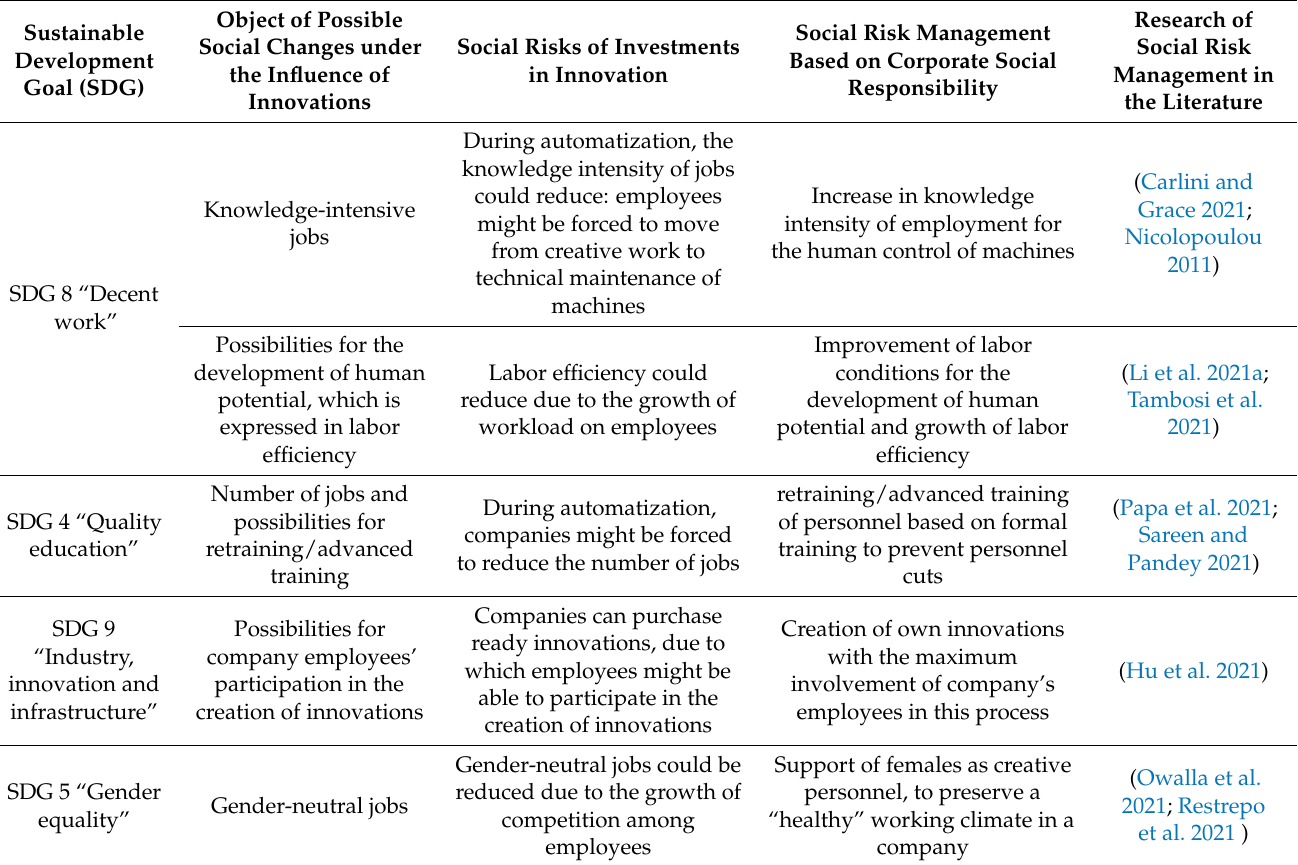
Table 1. Social risks of managing the investments in innovation and the approach to this